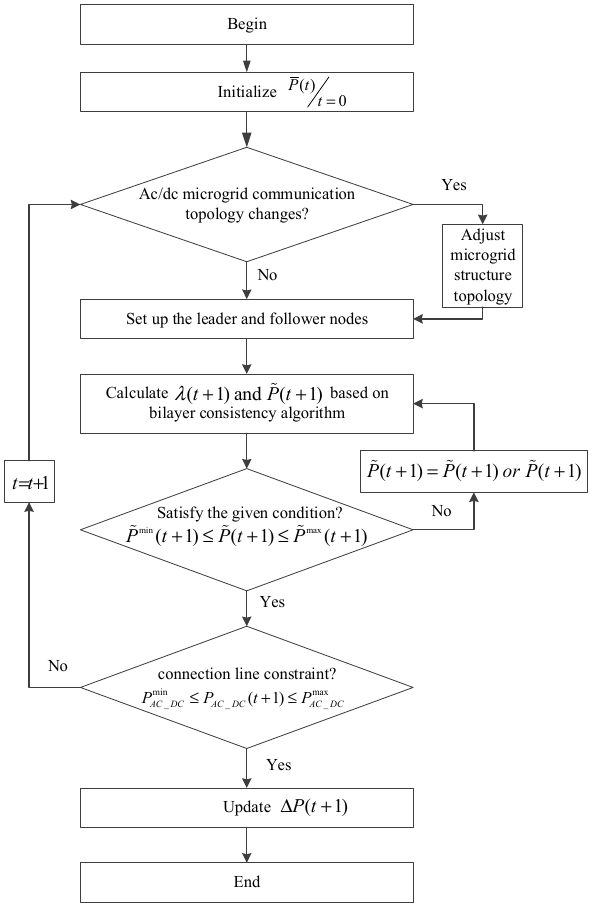
Figure 2. Flow chart of the dynamic economic dispatch (ED) strategy based on the two-layer consensus algorithm.